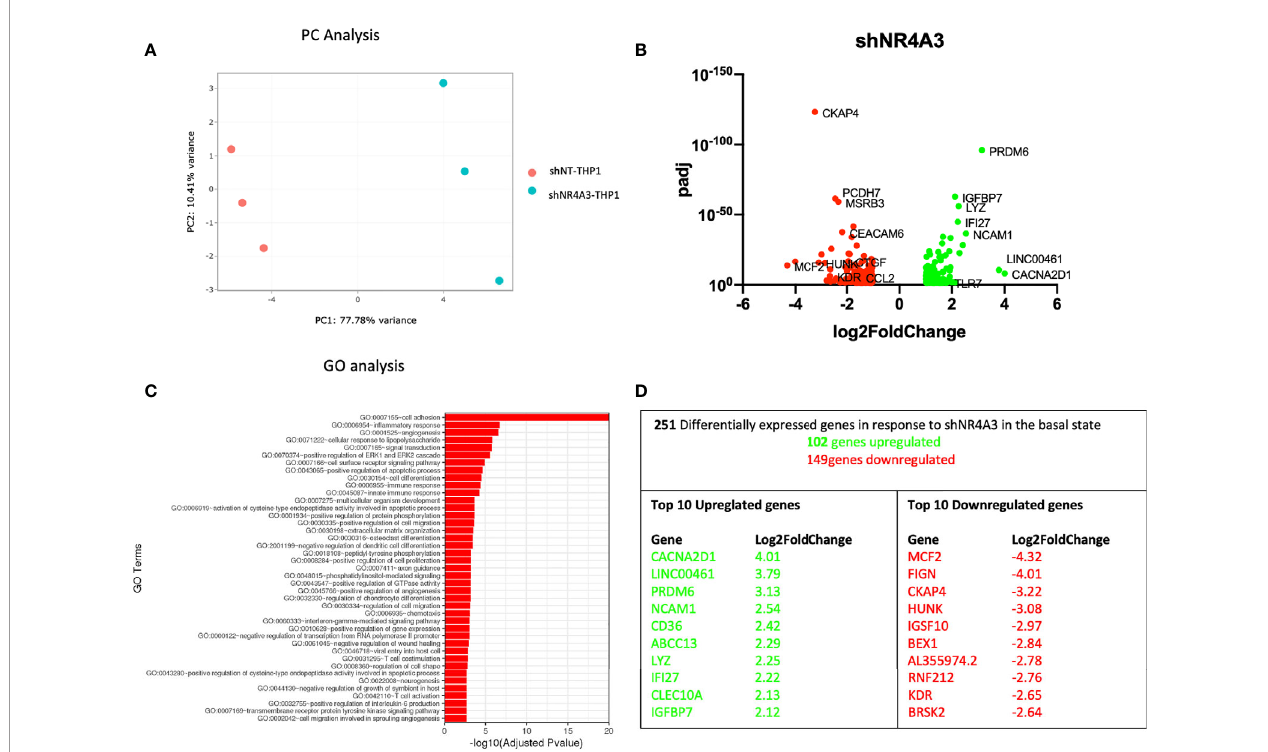
FIGURE 3 | Knockdown of NR4A3 has a distinct transcriptional pro fi le in the basal state. Principal component analysis (PCA) plot of transduced cells based on RNA-seq data between shNT and shNR4A3 cells (A) . Volcano plot of signi fi cant DEGs (p<0.05) upregulated (log2fc>/=1) (green) or downregulated (log2fc</=-1) (red) by knockdown of NR4A3 in THP-1 cells based on RNA-seq data (B) . Top gene ontology (GO) terms associated with knockdown of NR4A3 in THP-1 cells based on RNA-seq data (C) . Summary table of signi fi cant DEGs upregulated (green) and downregulated (red) by knockdown of NR4A3 in THP-1 cells based on RNA-seq data (D)